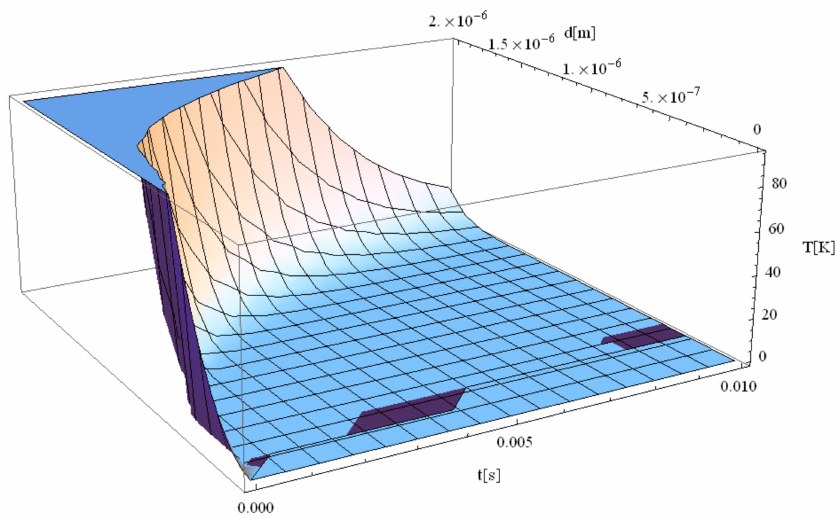
Figure 10. Electron temperature versus radius during 0.01 s simulation after irradiation with a 100-laser pulse applied to an Au